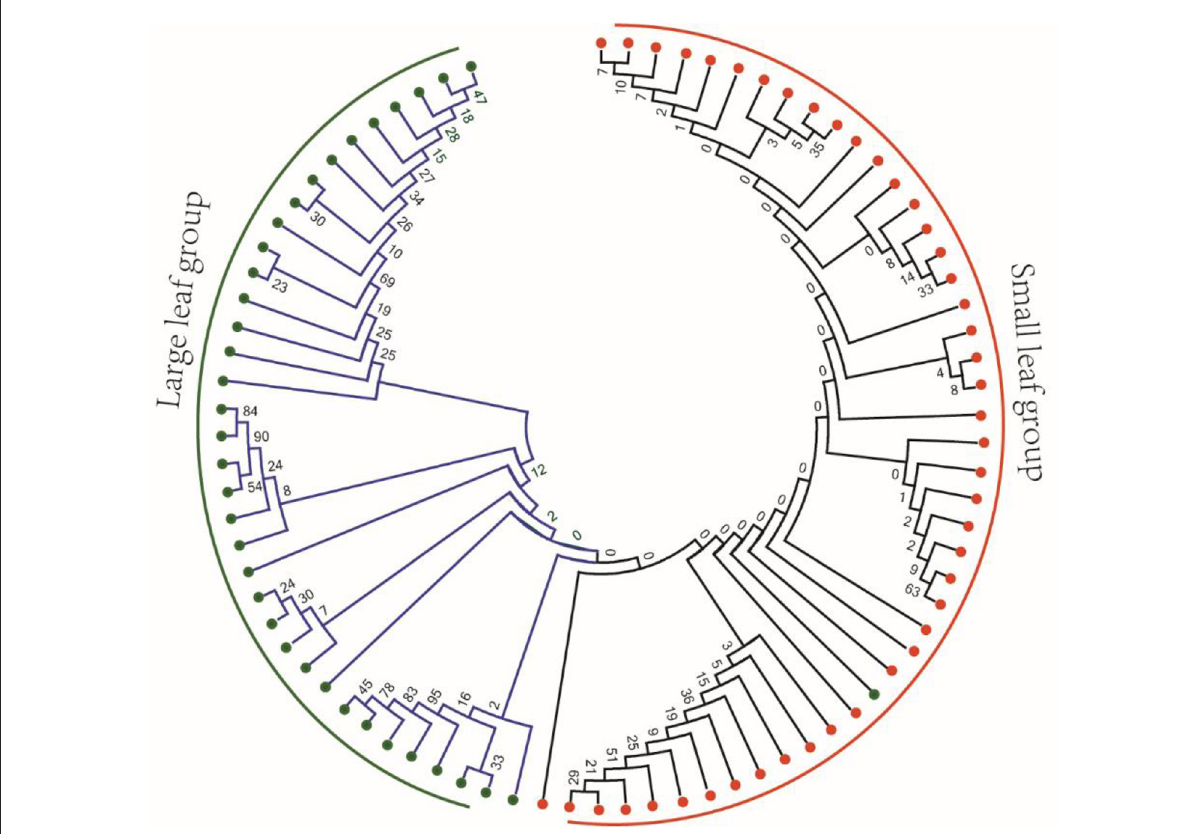
FIGURE8 Phylogenetic analysis of 82 tea plant samples based on 69 resequenced SNP loci of OVATE family.